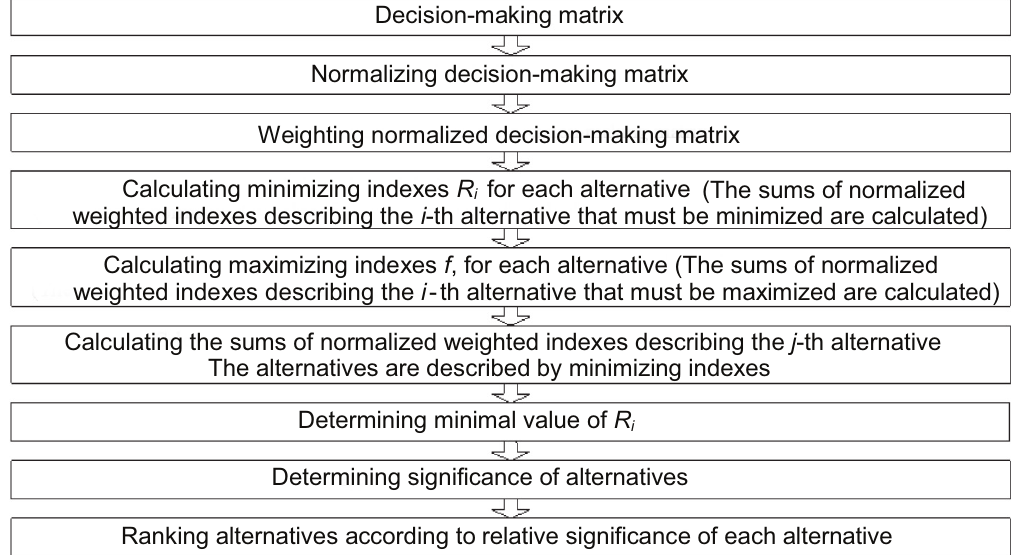
Decision-making